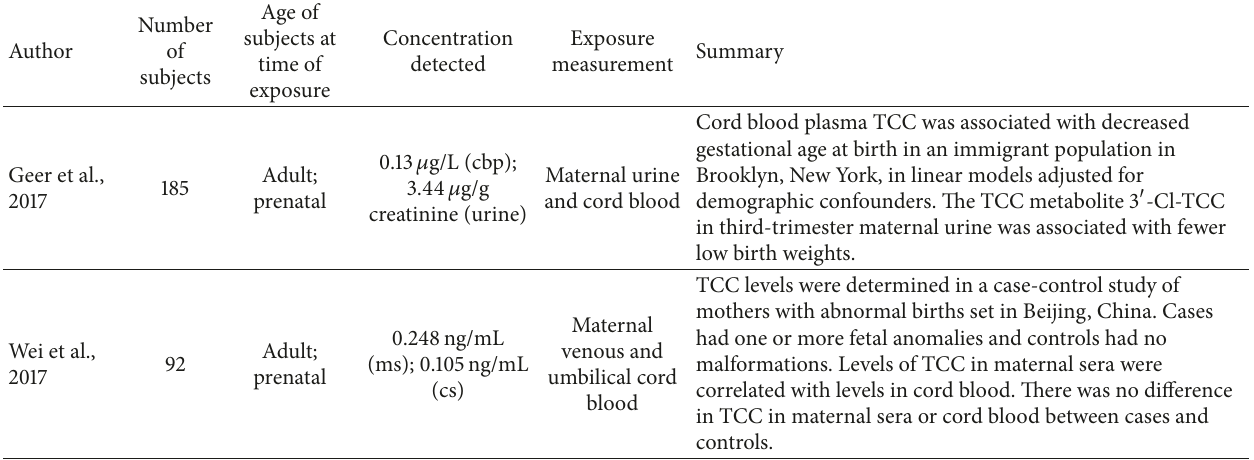
Table 2: Human studies evaluating the developmental effects of